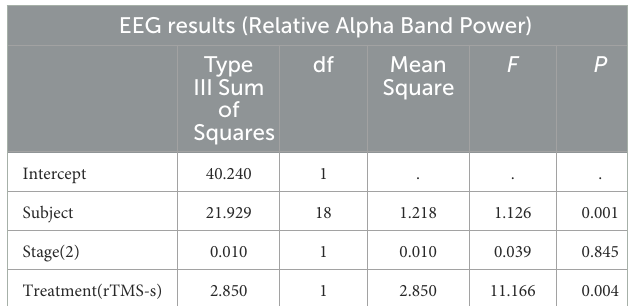
TABLE 3 Univariate general linear model ANOVA for EEG relative alpha band